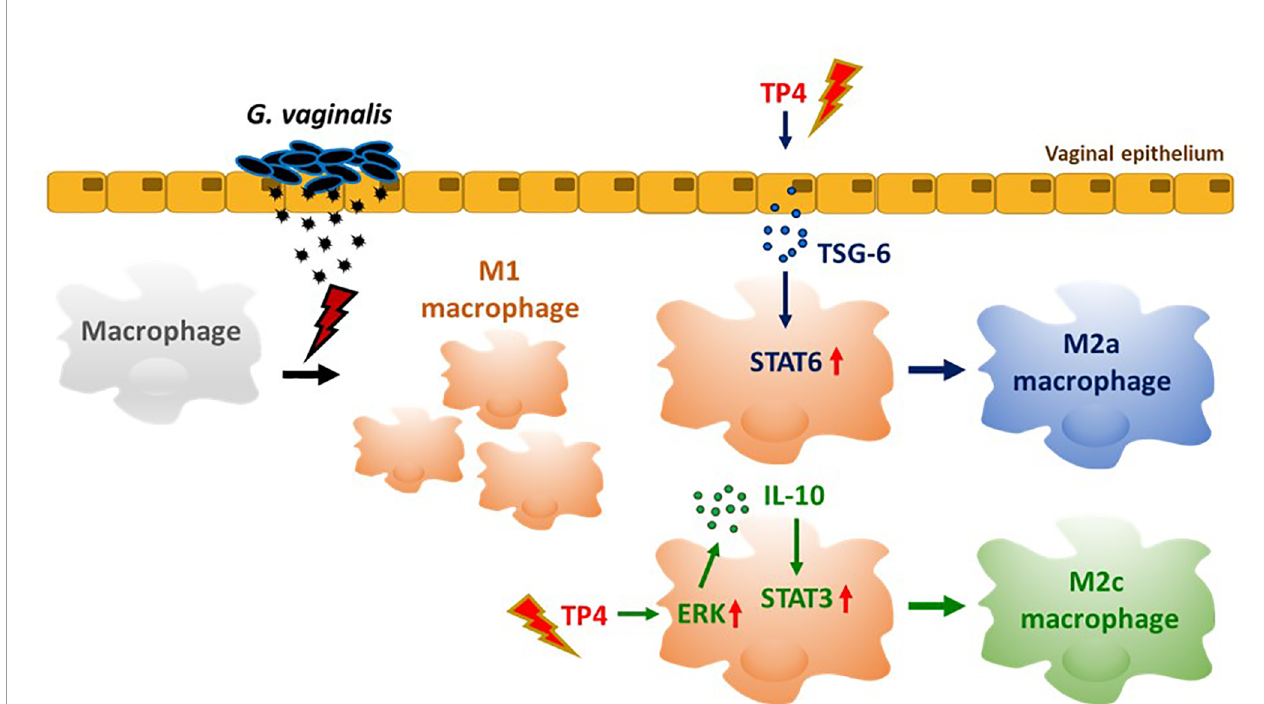
FIGURE 8 | TP4-mediated macrophage reprogramming. G. vaginalis -secreted virulence factors cause macrophages to exhibit a pro-in fl ammatory M1 type polarization. Treatment with TP4 switches the M1 macrophages toward resolving (M2c) or tissue repair (M2a) phenotypes. Direct application of TP4 to macrophages induces IL-10 expression via the MAPK/ERK pathway, which results in activation of downstream STAT3 signaling and promotion of M2c-related phenotypes. On the other hand, TP4 promotes vaginal epithelial cells to secret TSG-6, which in turn induces activation of downstream STAT6 signaling and promotes M2a-related